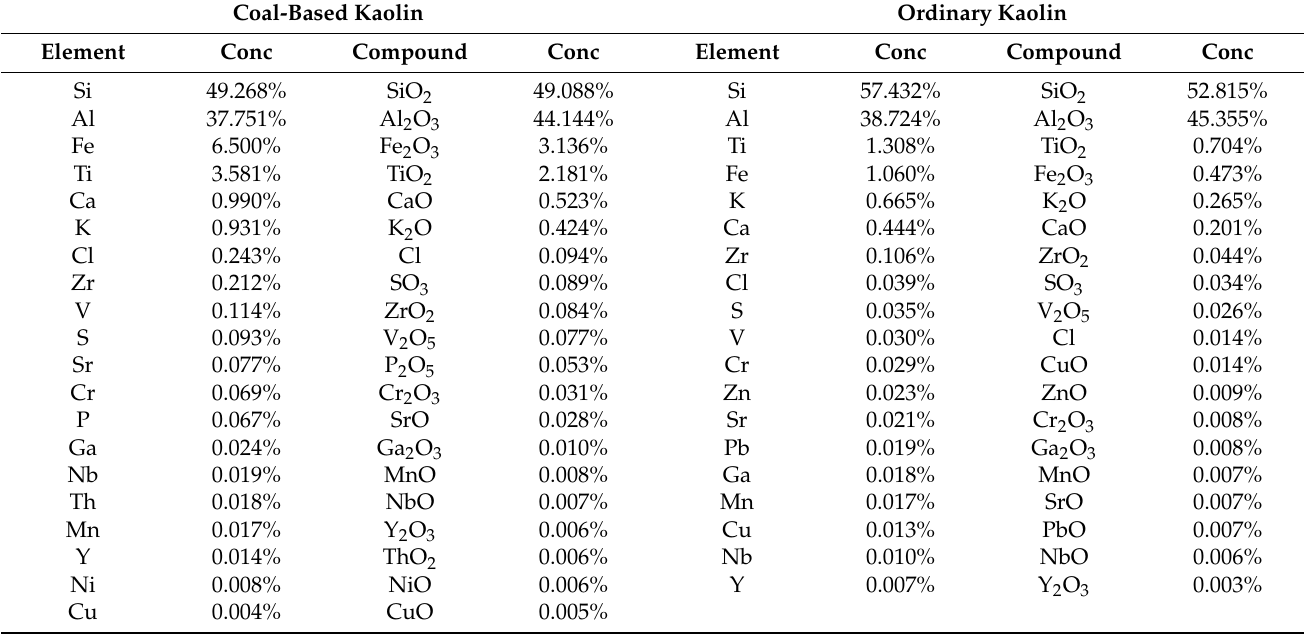
Table 1. Composition of coal-based kaolin and ordinary kaolin (by